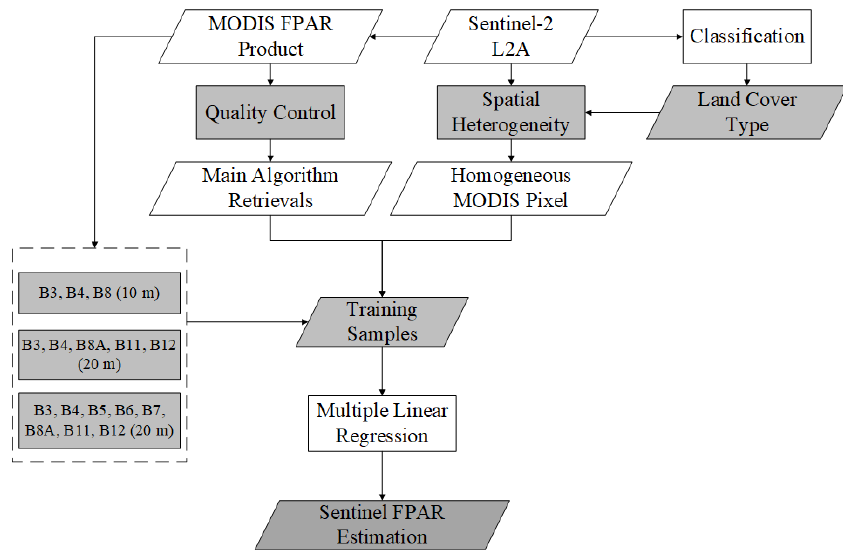
Figure 2. Flowchart of the scaling-based retrieval chain for Sentinel-2 FPAR estimation.